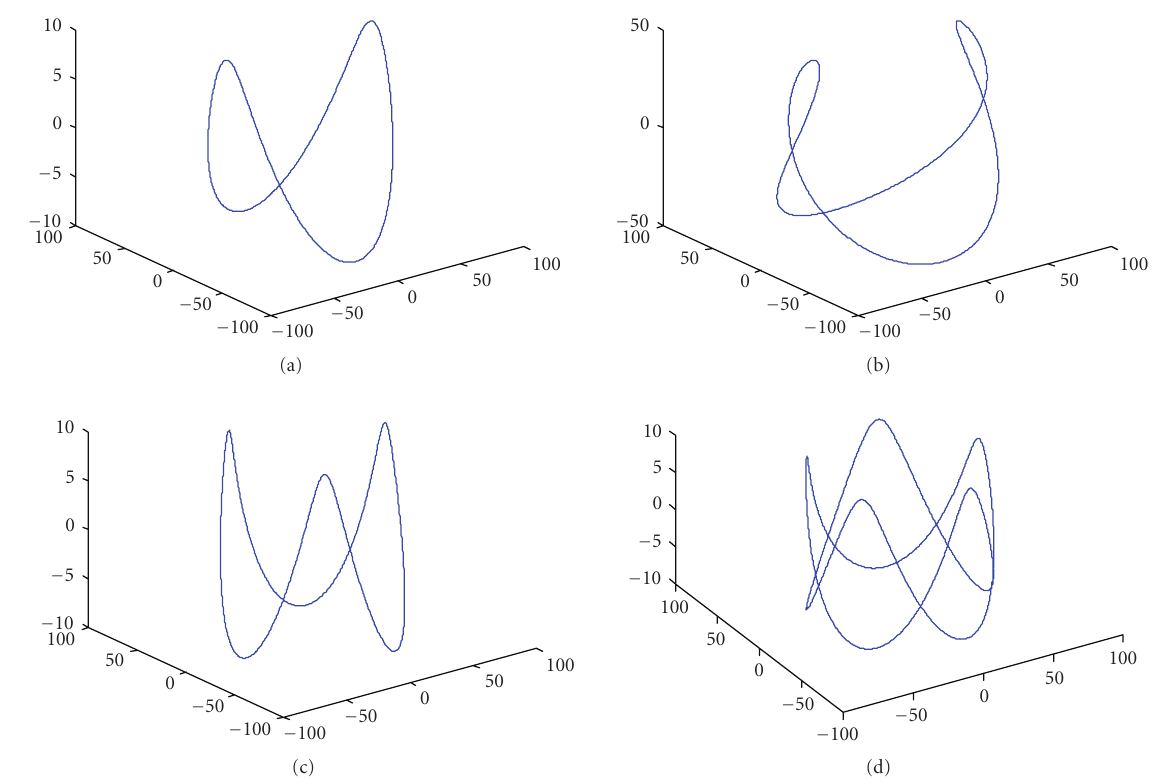
Figure 1: Composite-circling scanning curves with di ff erent parameter combinations. (a) m = 2, R 1 a = R 1 b = 10, R 2 = 57; (b) m = 2, R 1 a = R 1 b = 50, R 2 = 57; (c) m = 3, R 1 a = R 1 b = 10, R 2 = 57; (d) m = 2 . 5, R 1 a = R 1 b = 10, R 2 =